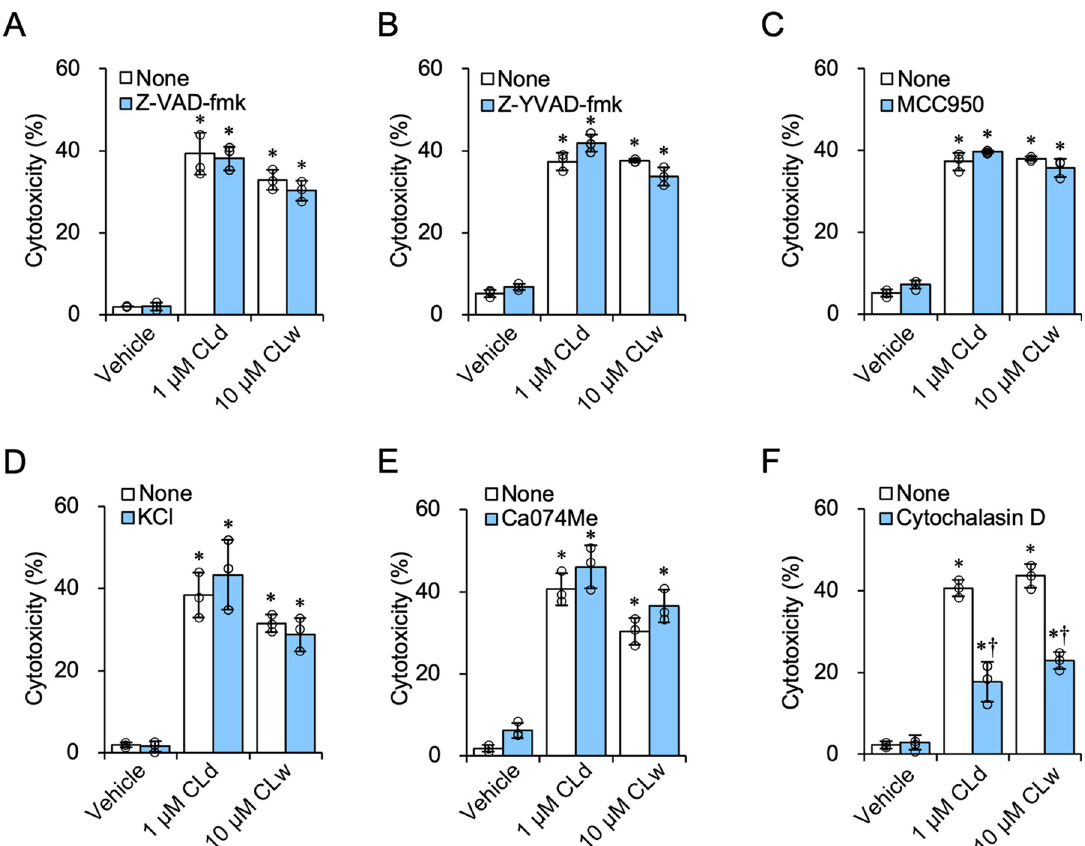
Fig 3. Influence of the inhibitors on the cytotoxicity of CLd and CLw. The differentiated THP-1 cells were pretreated with the following inhibitors: 20 μ M of the pan-caspase inhibitor Z-VAD-fmk (A); 20 μ M of the caspase-1 inhibitor Z-YVAD-fmk (B); 2 μ M of the NLRP3 inhibitor MCC950 (C); 25 mM KCl for inhibition of K + efflux (D); 20 μ M of the cathepsin B inhibitor Ca074Me (E); and 20 μ M of the phagocytosis inhibitor cytochalasin D (F) or with vehicle for 1 h. The vehicle control is a medium containing 2% DMSO. Cells were then treated with 1 μ M CLd or 10 μ M CLw for 3 h. Cytotoxicity was quantified by LDH release assay. Data are presented as the mean ± SD (n = 3) and are representative of three independent experiments. � P < 0.05 compared with the vehicle ( μ c < μ i); † P < 0.05 compared with the none ( μ c > μ i) by one-way ANOVA followed by Dunnett’s test.